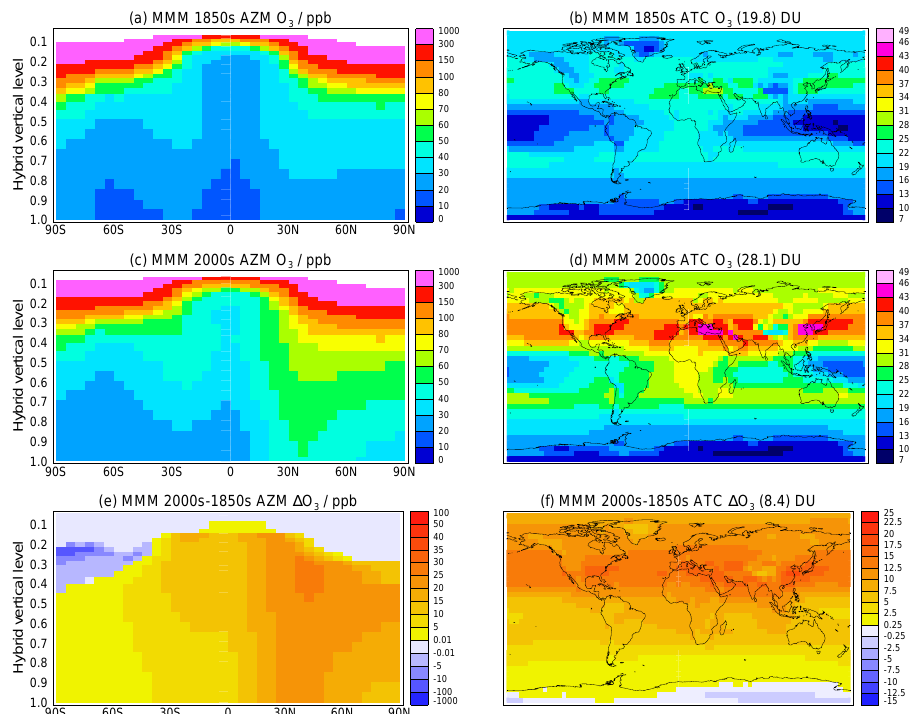
Fig. 1. Multi-model mean (MMM) annual zonal mean (AZM) ozone (ppb) and annual mean tropospheric column (ATC) ozone (DU), for the: 1850s (a–b) , 2000s (c–d) and for the change 2000s–1850s (e–f) . The MASKZMT tropopause is used, and area-weighted global mean values of ATC are given in brackets. Figure S1 (Supplement) shows equivalent plots for all individual